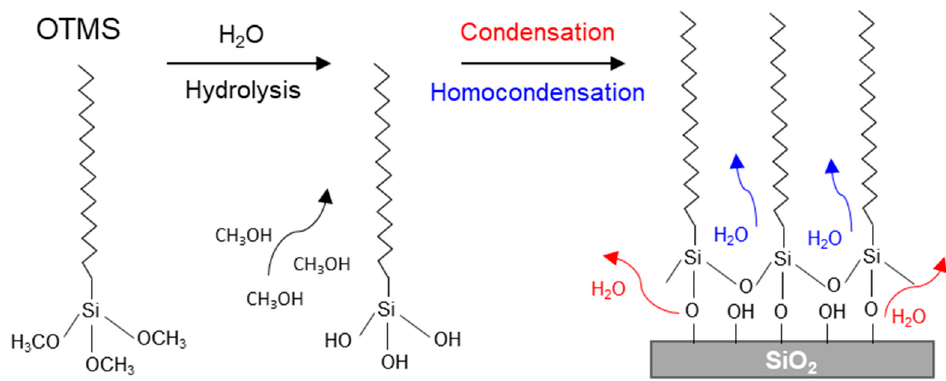
Figure 9. An illustration showing an OTMS molecule and the hydrolysis of its methoxy groups, resulting in the formation of silanols (Si–OH) and the evaportation of methanol molecules. An OTMS monolayer is formed on a SiO 2 substrate via the condensation reaction between silanols and hydroxyl groups from the substrate to anchor the molecule to the substrate and homocondensation reaction between silanols to establish the polymerized –Si–O–Si–